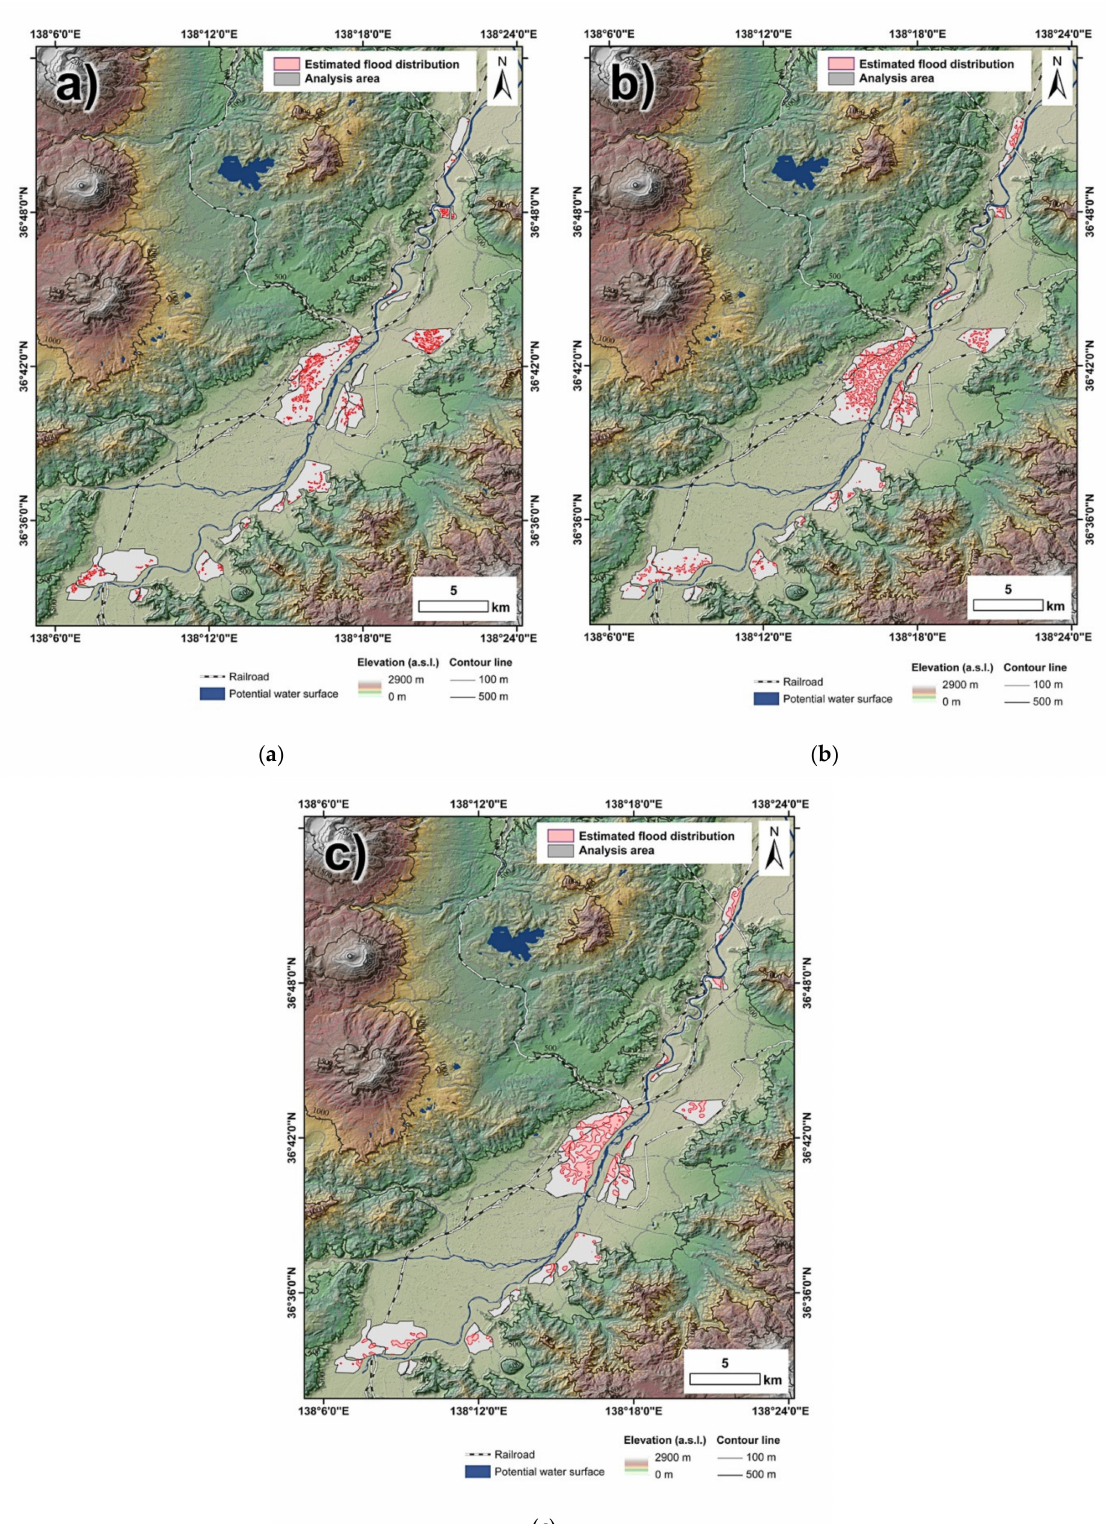
Figure 2. Detection results of the flooded area for ( a ) the multi-temporal intensity analysis, and the multi-temporal coherence analysis using ( b ) path 19 and ( c ) path 20 for the pre-event